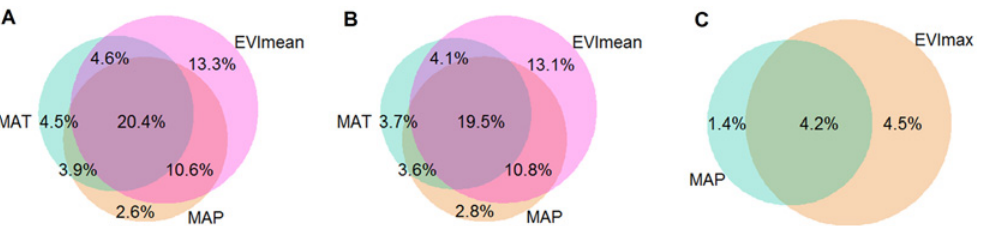
Fig 4. Contributions of critical factor to the spatial variations in AGPP(A), ARE(B), ANEP(C). Contributions of MAT, MAP, and EVI mean to the spatial variations in AGPP(A) and ARE(B); Contributions of MAP and EVI max to the spatial variation in ANEP (C).